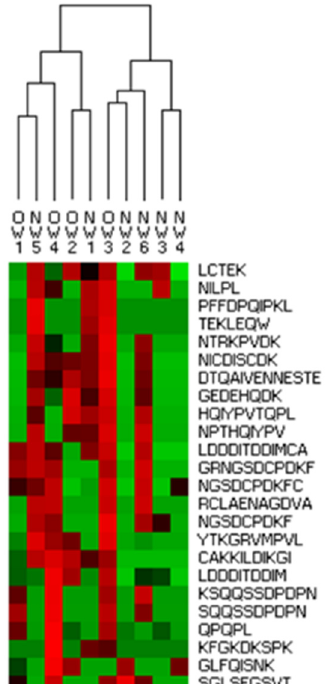
Figure 6. Heat map representation (fragment) of the hierarchical clustering analysis of peptides identified after in vitro digestion of breast milk. Columns correspond to subjects included in the overweight/obese group or normal weight group. Rows correspond to intensity of sequences derived from β -casein, α -lactalbumin and lactoferrin identified in at least 3 subjects. Complete figure in Figure S1.